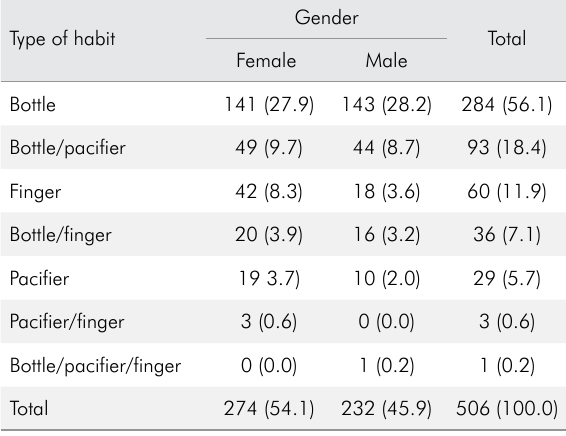
Table 1. Characterization of the study sample - n(%).